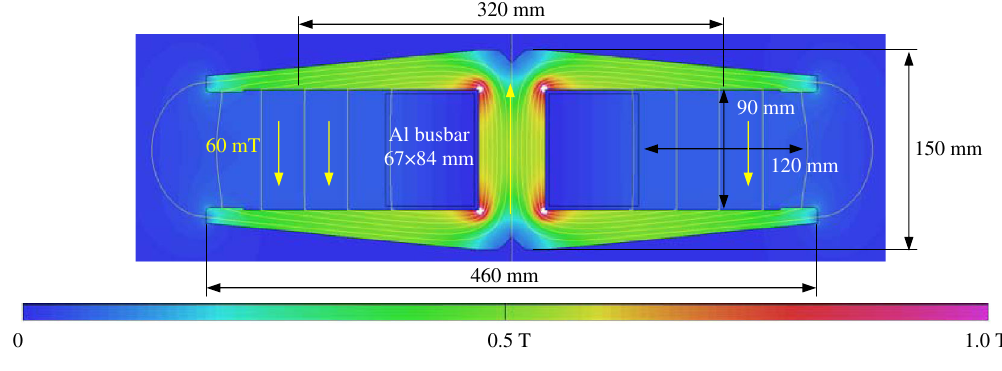
FIG. 6. First cross section of FCC-ee bending magnets with an I layout (field levels for 175 GeV).